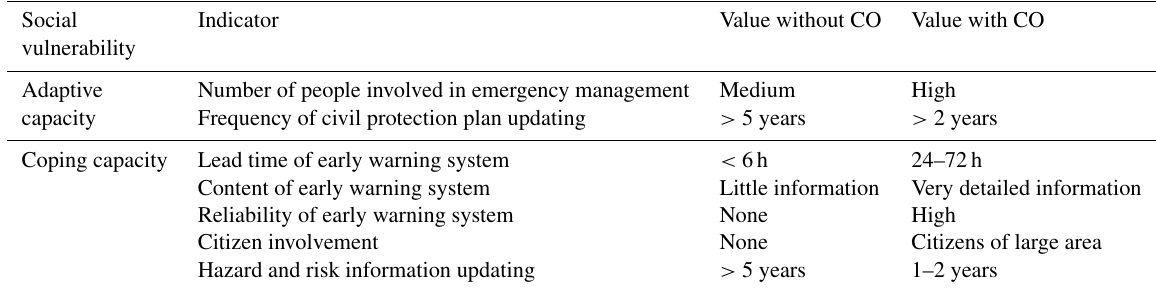
Table 6. Changes in the indicators of social vulnerability with and without implementation of the CO on flood risk management. Social Indicator Value without CO Value with CO